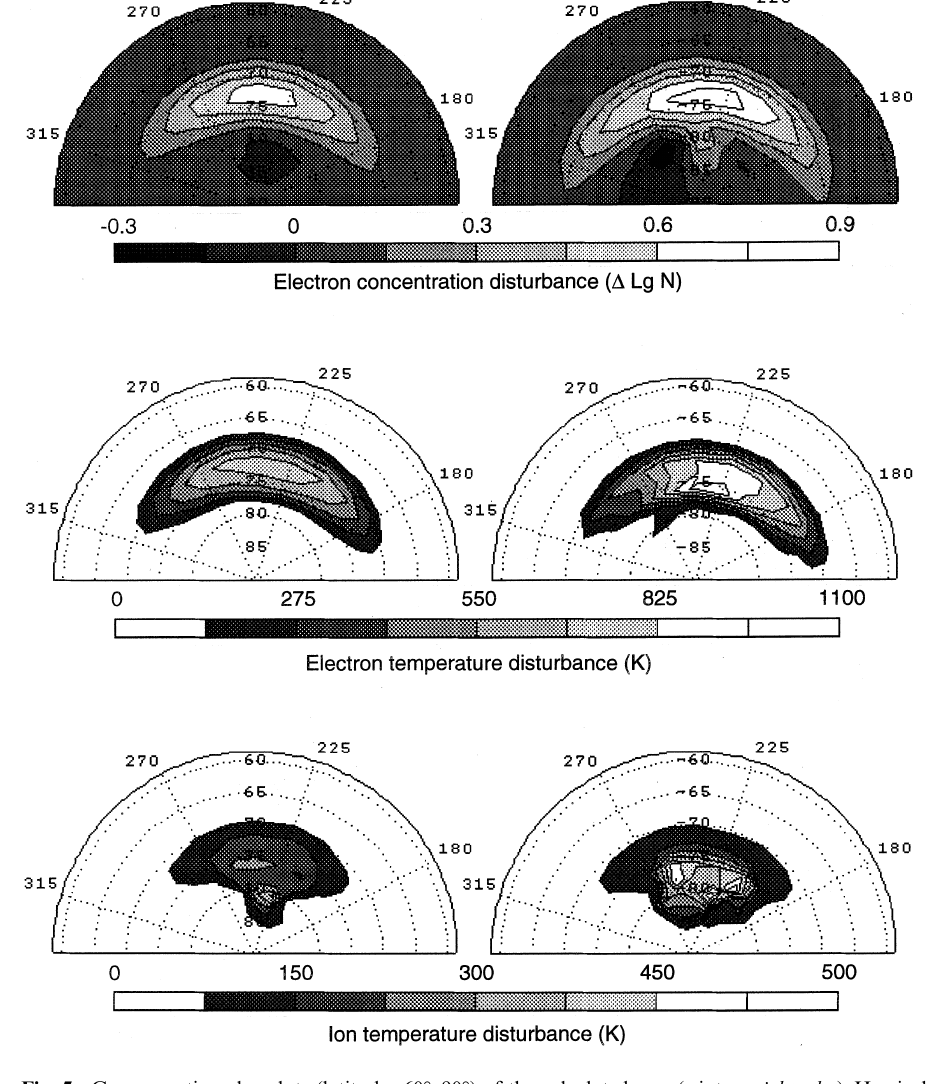
(winter, right plot ) Hemispheres at 0030 UT which is the time of maximum of the ionospheric disturbances. The Sun position is at the